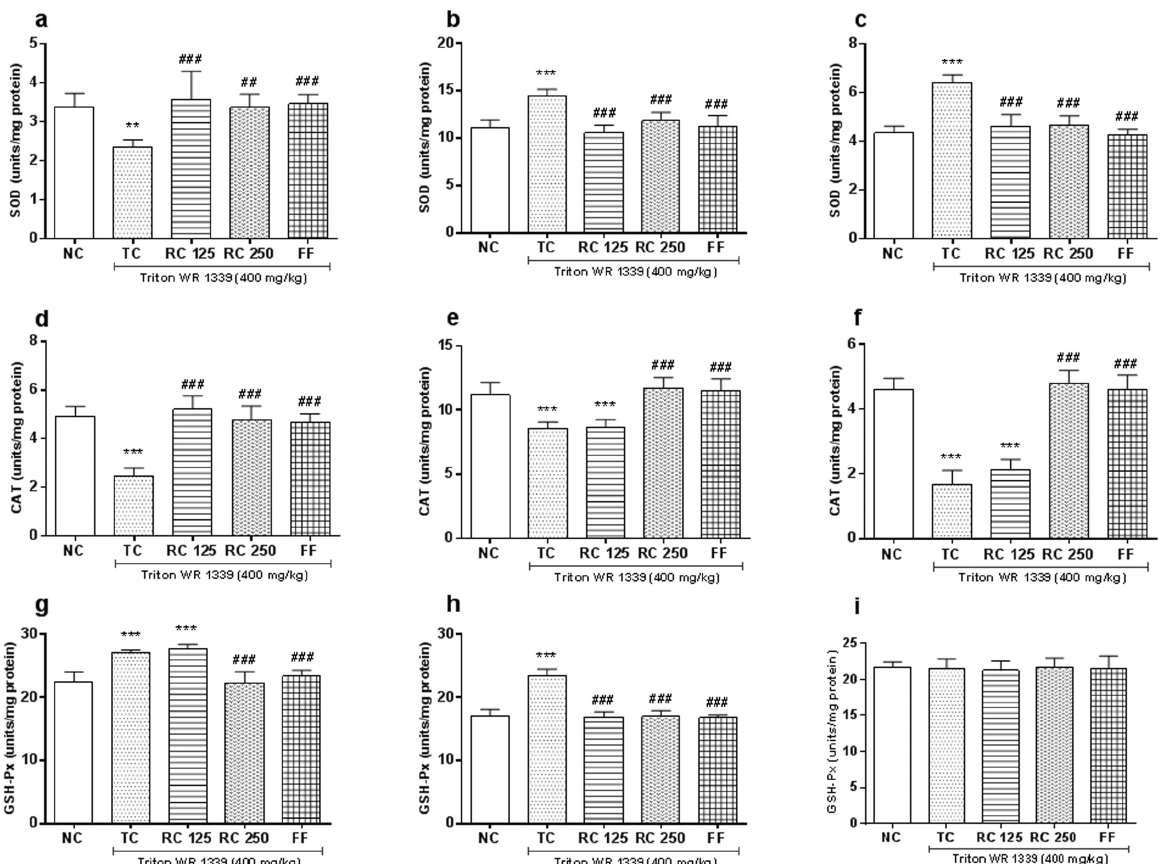
Figure 3. Effects of red cabbage aqueous extract (RC) and fenofibrate (FF) treatments on antioxidant enzymes activities in kidneys (left, panels a, d and g), liver (middle, panels b, e and h) and erythrocytes (right, panels c, f and i) of Triton WR-1339-induced hyperlipidemia in rats. Bars represent means± S.D. (n=5–6). ** p <0.001, *** p <0.001 vs normal control (NC) and ## p <0.01, ### p <0.001 vs Triton control (TC), according to one-way ANOVA followed by Tukey’s test. SOD= superoxide dismutase; CAT= catalase; GSH-Px= glutathione